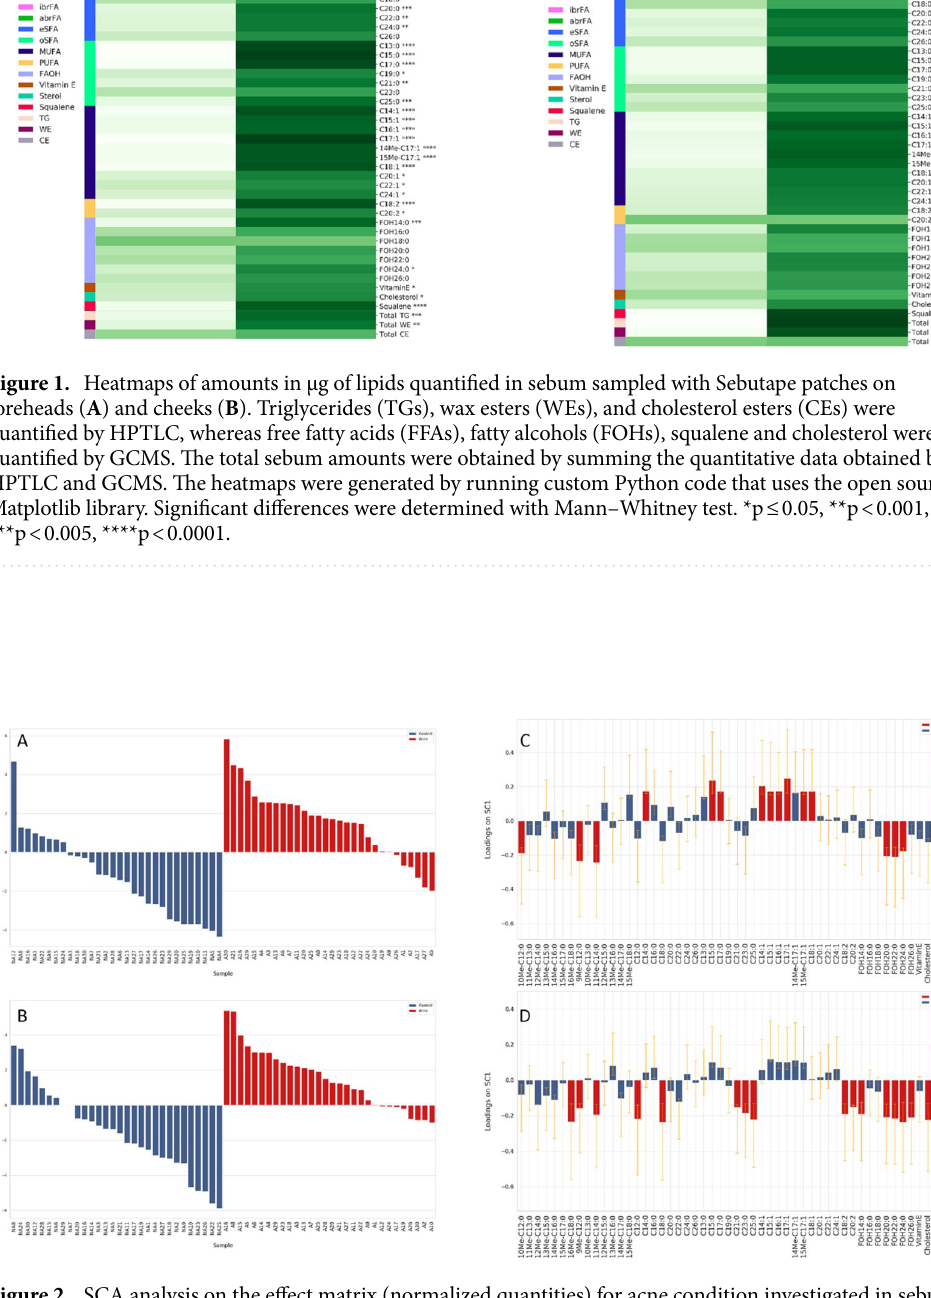
Figure 2. SCA analysis on the effect matrix (normalized quantities) for acne condition investigated in sebum from foreheads ( A – C ) and from cheeks ( B – D ). ( A , B ) Scores plots after projection of the residuals onto the space spanned by the only significant PC; legend: blue = non-acne; red = acne. ( A ) and ( B ) plots refer to the scores of foreheads and cheeks, respectively. ( C , D ) Variable loadings on SC1, together with their confidence interval (red and blue bars indicate significantly and not significantly contributing descriptors, respectively). ( C ) and ( D ) bar graphs refer to the loadings on the SC1 of individual lipids in foreheads and cheeks,